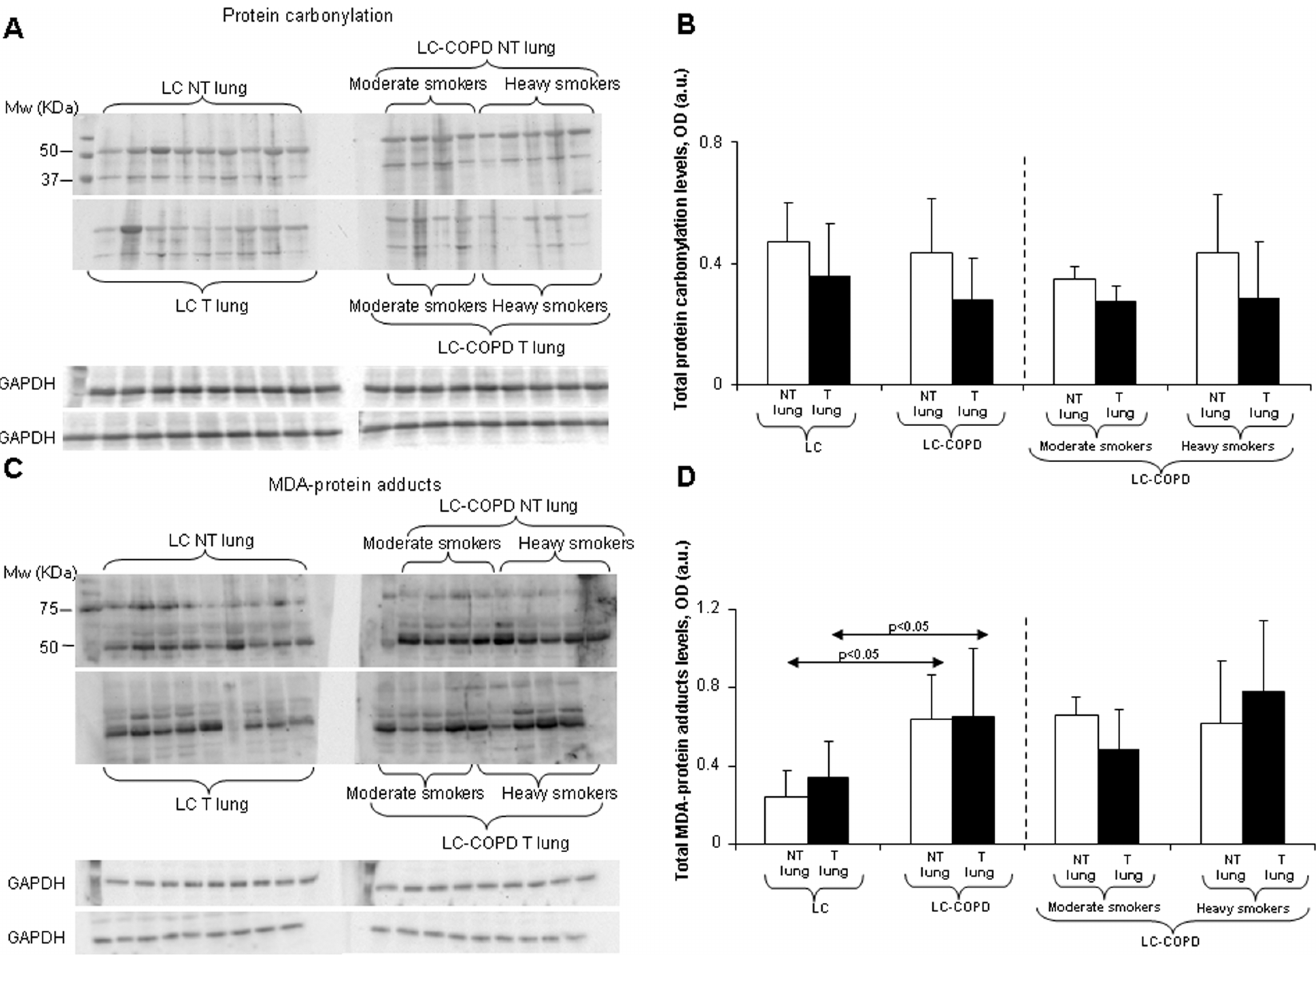
Figure 1. (A) Immunoblots of total protein carbonylation in the lung tumor (T) and nontumor (NT) of LC and LC-COPD patients. (B) Mean values and standard deviation (optical densities [OD] expressed in arbitrary units [a.u.]) of total protein carbonylation levels in lung did not significantly differ between tumor (T) and nontumor (NT) lung samples and between any of the study groups of patients. The absence of any statistical sign means that no significant differences were found between groups for the different study comparisons. (C) Immunoblots of MDA–protein adducts in the lung tumor (T) and nontumor (NT) of LC and LC-COPD patients. (D) Mean values and standard deviation (OD expressed in a.u.) of total MDA–protein adduct levels in the lung were greater in LC-COPD as a group in both tumor (T) and nontumor (NT) lung samples compared with LC patients. The absence of any statistical sign means that no significant differences were found between groups for the different study comparisons. MW, molecular weights; KDa,